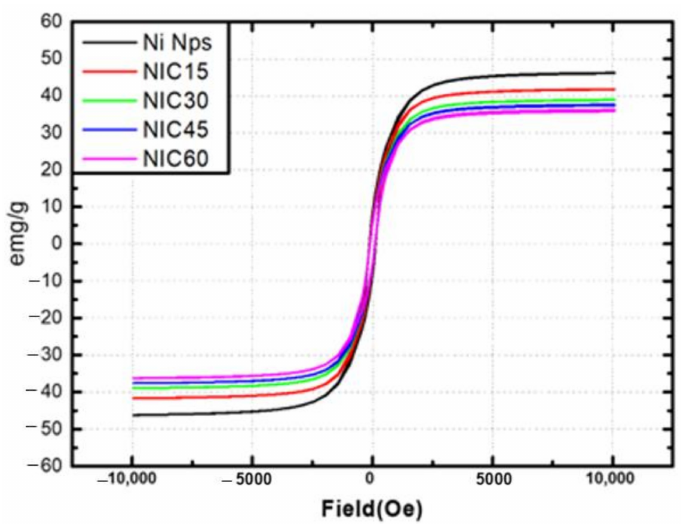
Figure 8. Field-dependent magnetization (M − (H) curves) of Ni Nps and NICs at 300